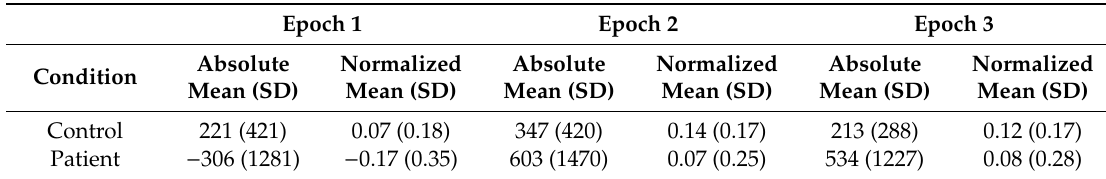
Table 2. Mean di ff erence between novel and repeated configurations and normalized contextual cueing e ff ects ((RTnovel − RTrepeated) /